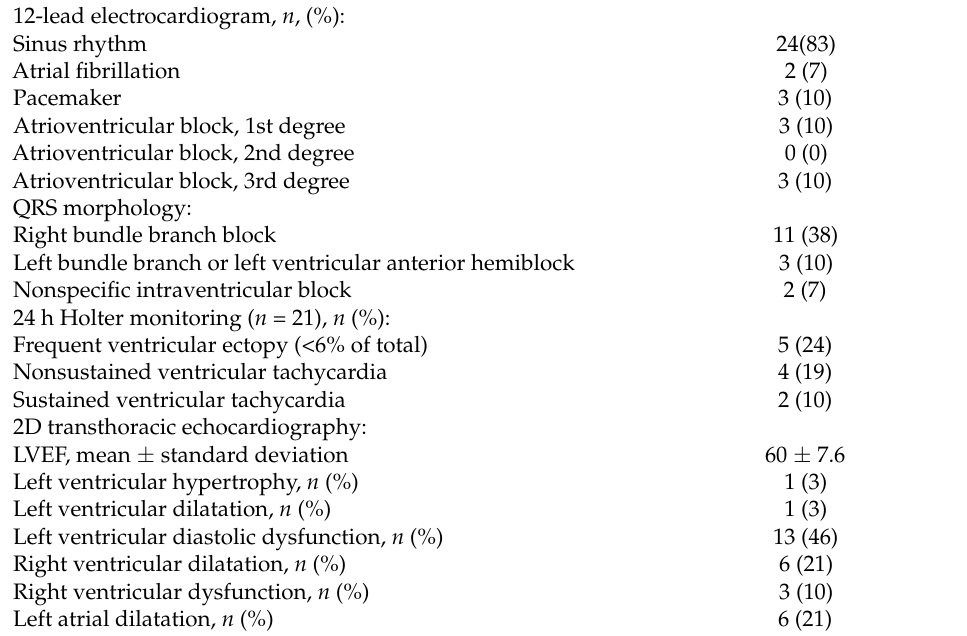
Table 2. Biochemical, electrocardiographic and echocardiographic features of cardiac sarcoidosis patients ( n =